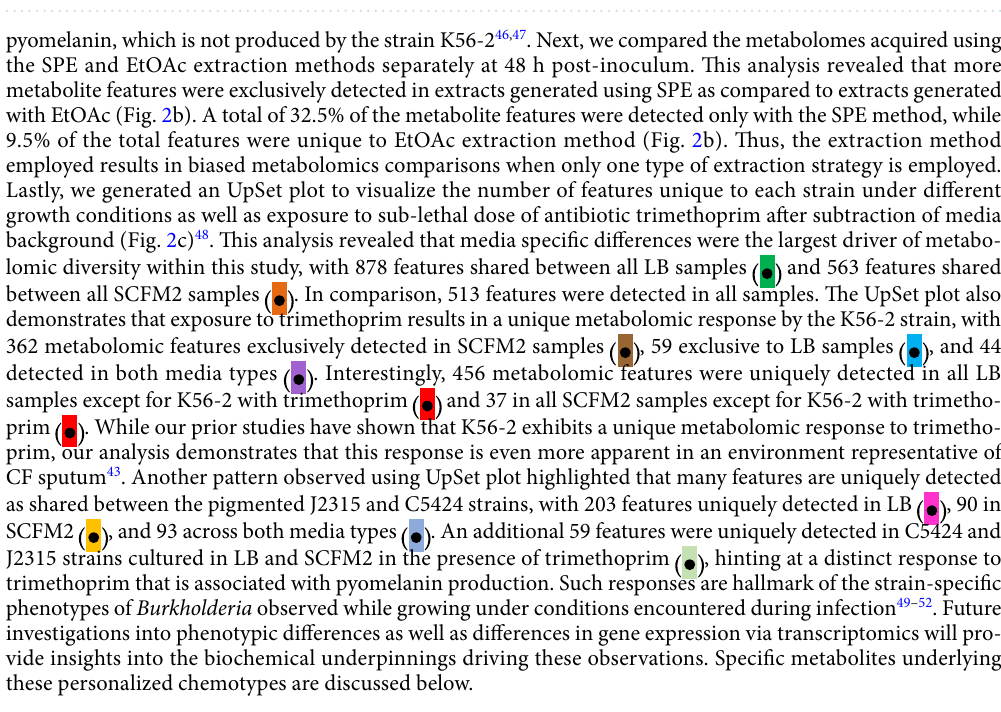
Figure 1. Summary of ( a ) experimental design and ( b ) data analysis workflow used in this